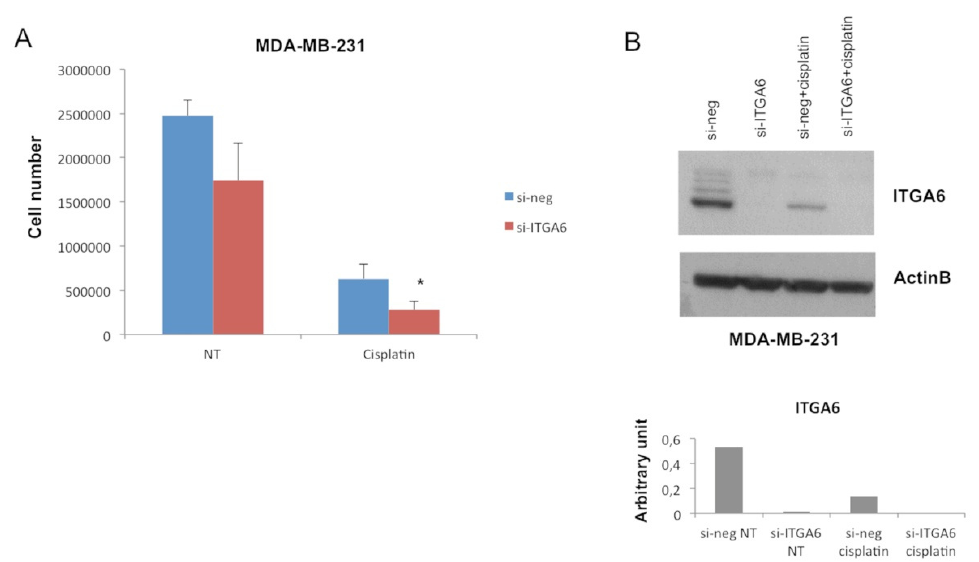
Figure 3. Combinatorial effect of small interfering ‐ ITGA6 (si ‐ ITGA6) and cisplatin in an in vitro TNBC model. ( A ) MDA ‐ MB ‐ 231 cell count following si ‐ ITGA transfection and cisplatin treatment compared with their negative controls. ( B ) Western blot analysis of ITGA6 protein expression in MDA ‐ MB ‐ 231 cells transfected with si ‐ ITGA6 and treated with cisplatin compared with their negative controls. Upper figure shows specific ITGA6 bands and β‐ actin bands as housekeeping; lower figure shows histograms representing ITGA6 densitometric quantification. Data are representative of three independent experiments performed at least in triplicate (* p ≤ 0.05, Student’s t ‐ test).